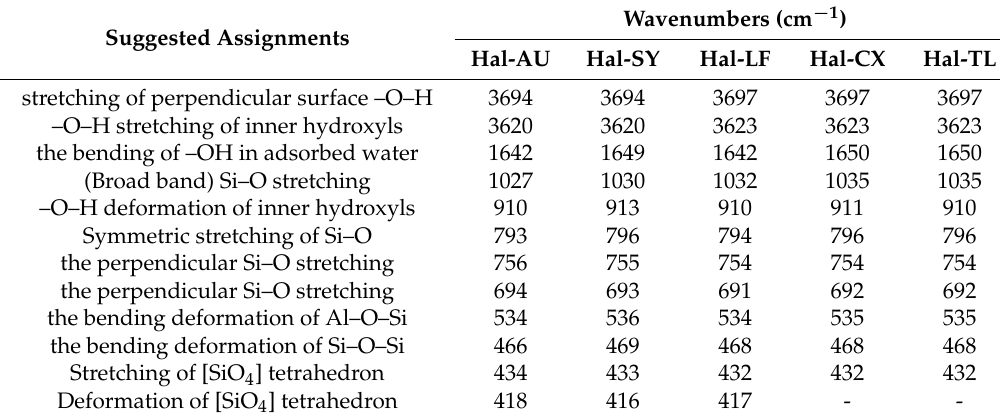
Table 2. Assignments of FTIR vibrations recorded for halloysite